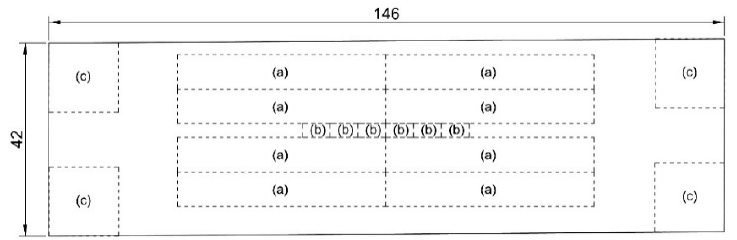
Figure 5. Position of the test specimens cut out from the slabs removed from the façade (dimensions in cm): ( a ) flexural strength; ( b ) compressive strength; ( c ) breaking load at dowel hole south